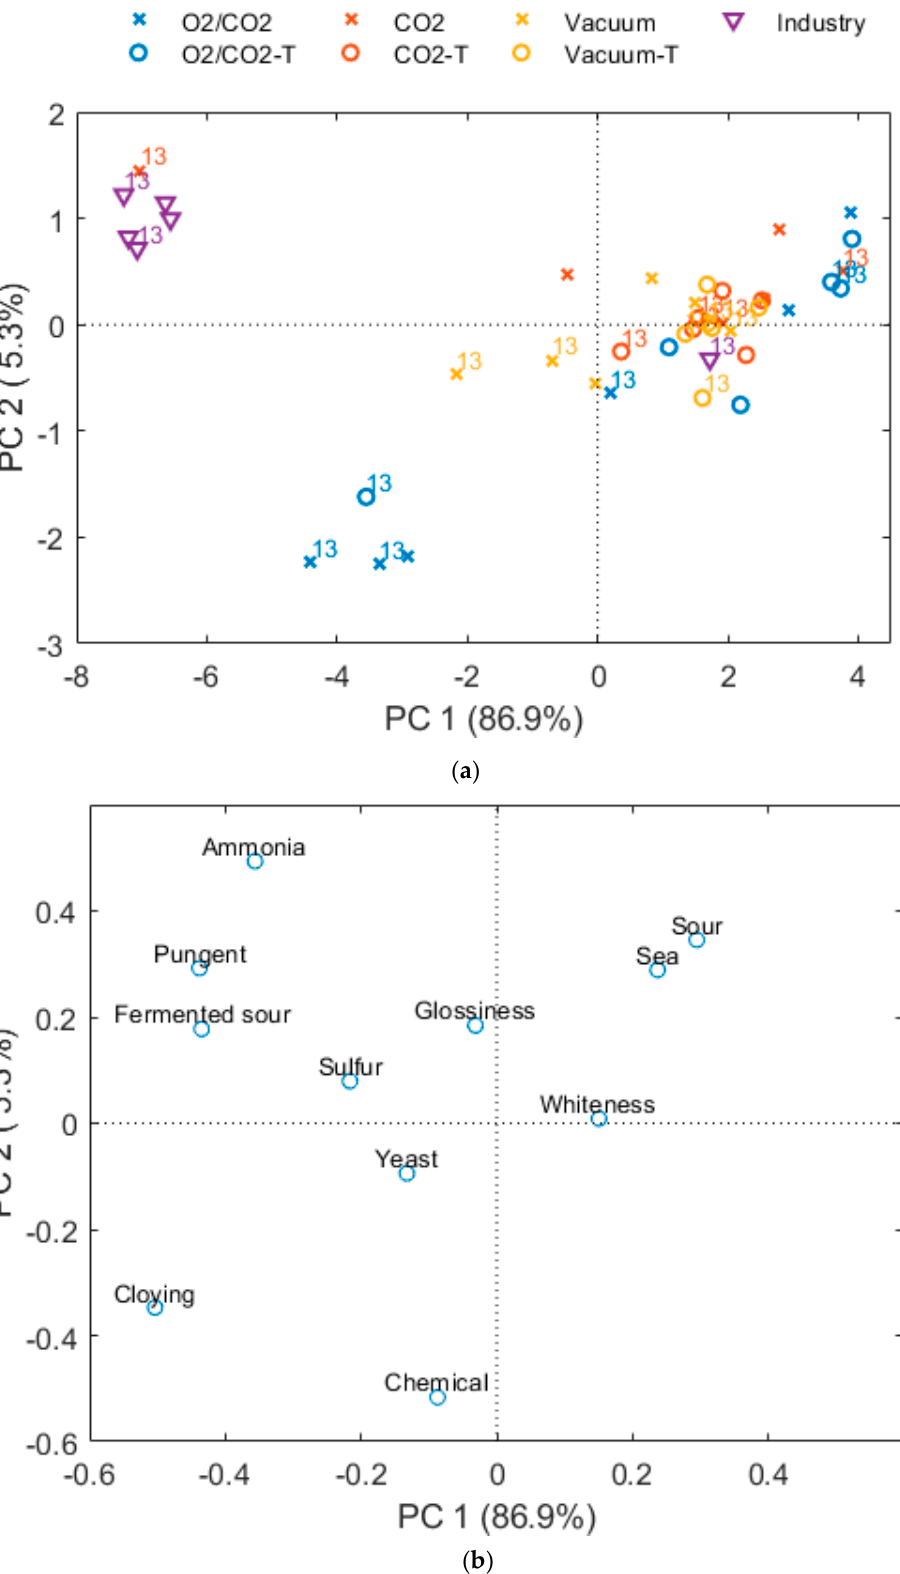
Figure 5. PCA analysis of sensory attributes evaluated after 8 days and 13 days of storage for the fresh (cross symbol) and thawed (circle symbol) samples. The “CO 2 ” samples (red color) are packaged with 60% CO 2 , 40% N 2 and a CO 2 emitter, and “O 2 /CO 2 ” (blue color) is packaged with 60% CO 2 and 40% O 2 . “Industry” samples (purple triangle symbol) and “Vacuum” samples (yellow color) are packaged with vacuum. ( a ) Scores plot (13 days of storage are indicated by label), ( b ) loading plot: odor attributes.